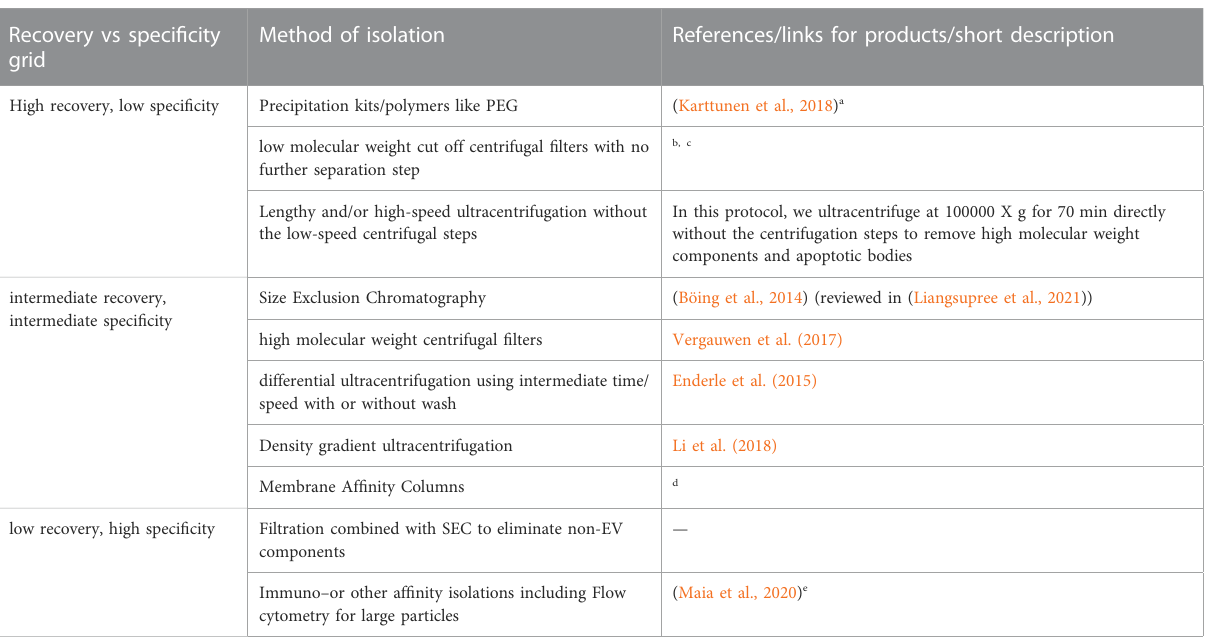
TABLE 4 This table summarizes various methods to isolate